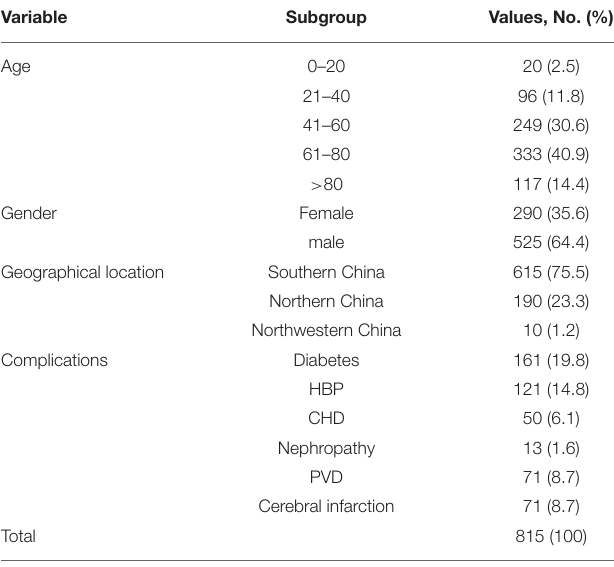
TABLE 1 | Participant demographics and clinical variables.